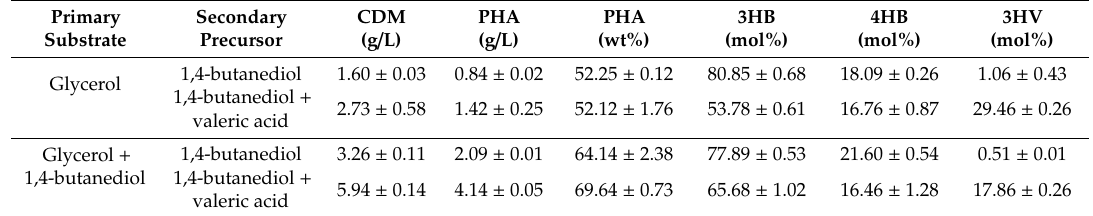
Table 3. Two-stage terpolymer production (48 h at glycerol or glycerol + 1,4-butanediol, after that transfer to nitrogen-limited medium with precursor of